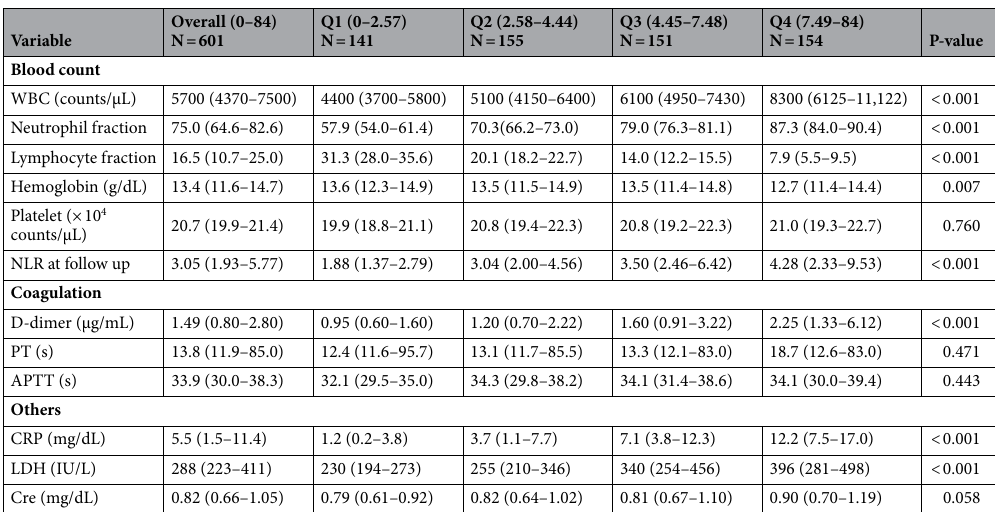
Table 2. Laboratory parameters of COVID-19 patients according to baseline NLR quartiles. Data are shown as percentage for categorical and as median (IQR) for continuous variables. PT Prothrombin time, APTT